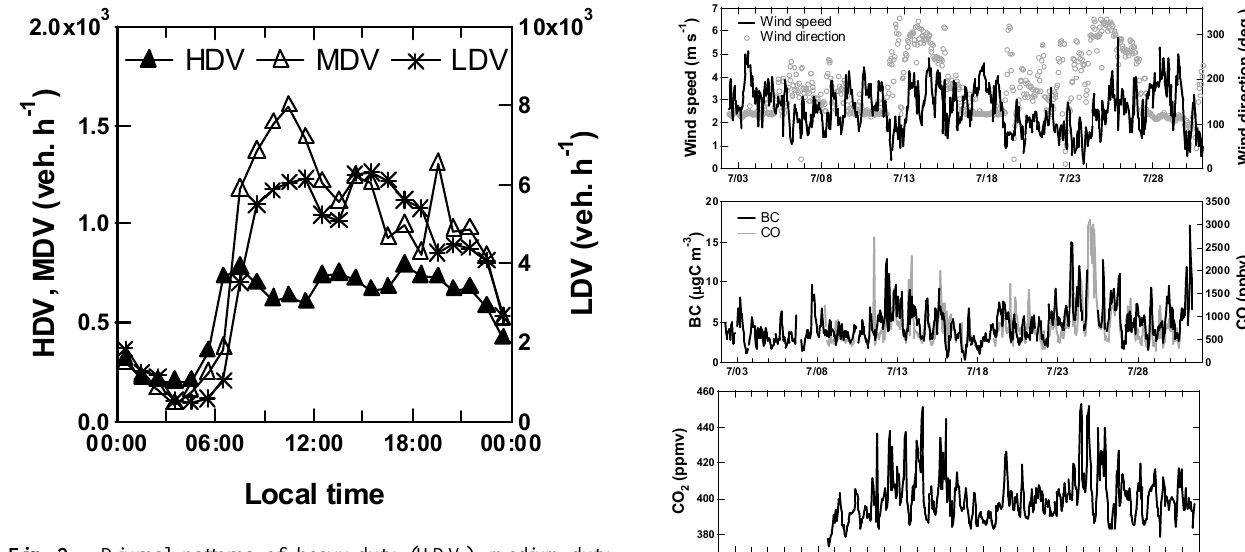
Fig. 2. Diurnal patterns of heavy-duty (HDV), medium-duty (MDV) and light-duty (LDV) vehicles on the Dongfeng middle road, recorded during 18–24 July 1999 and 12–18 October 1999 (Xie et al., 2003). Fig. 3. Time series variations of hourly averaged concentrations of BC, CO, CO 2 and some meteorological